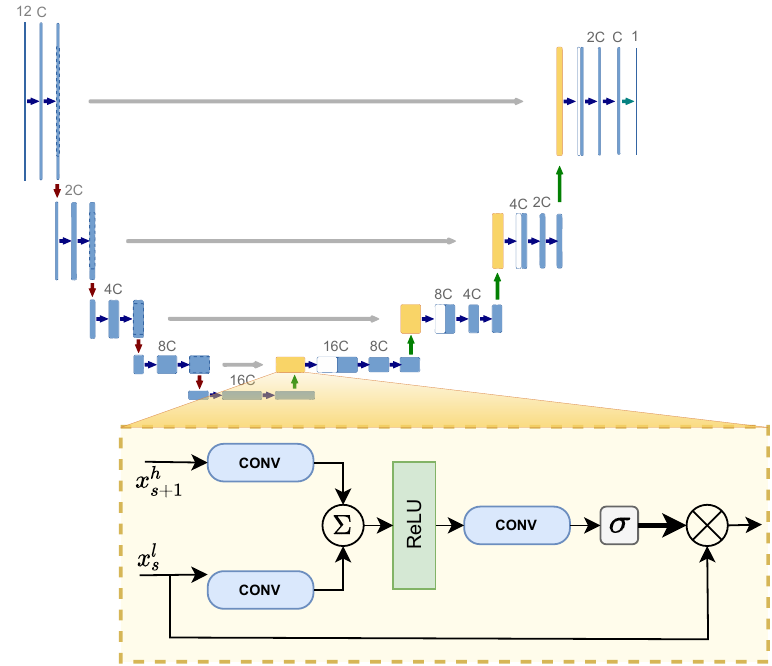
Figure 3. Visual representation of the Spatial Attention block of